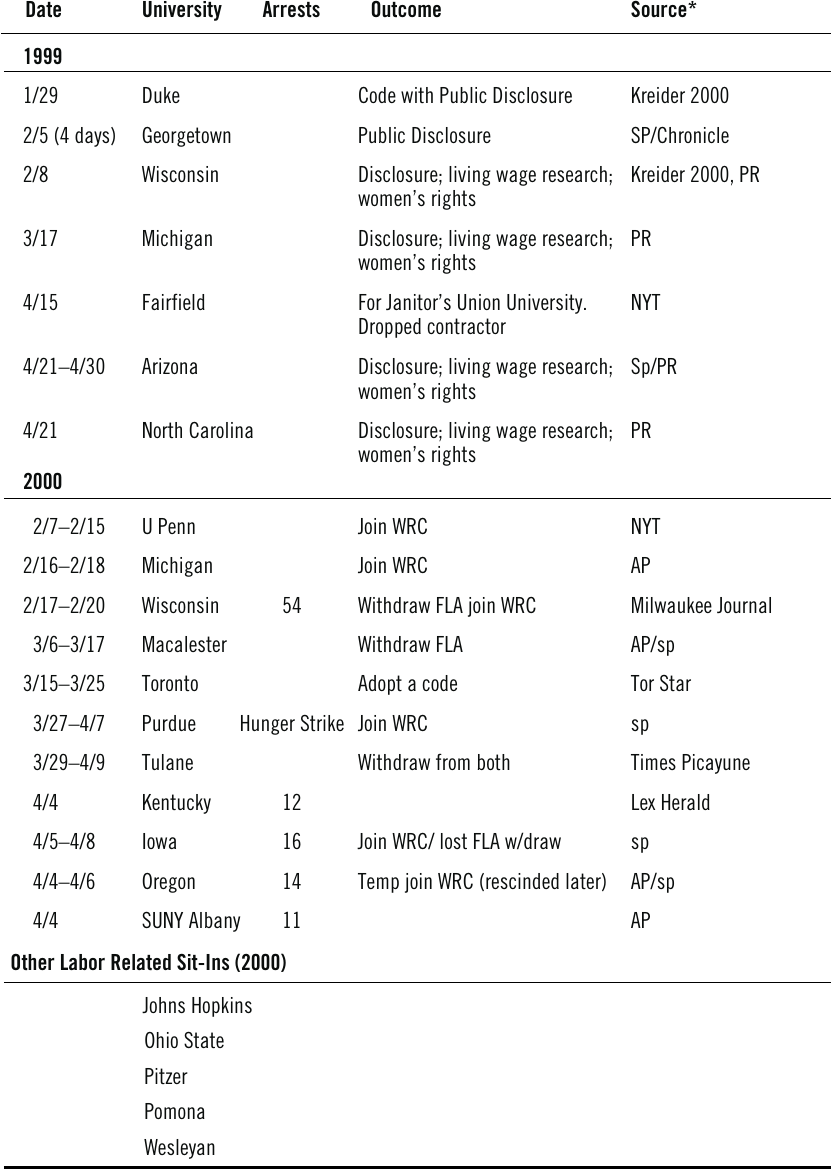
Table 1: Sit-Ins on the Campus Logo/Sweatshop Issue